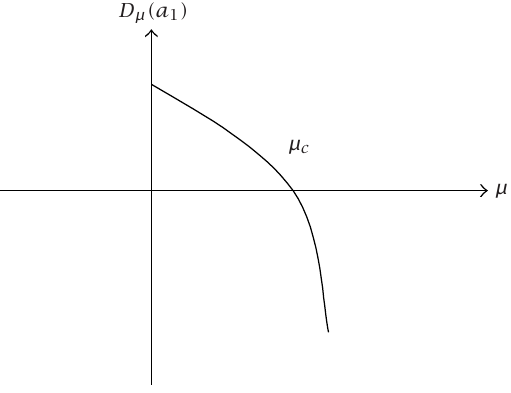
Figure 2.1 . The uniqueness of the bifurcation parameter µ c